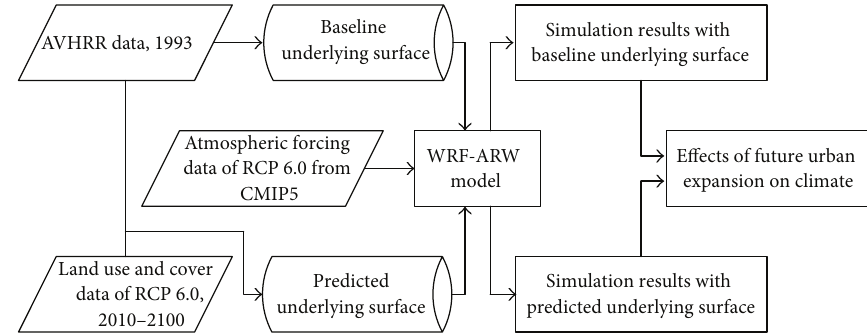
Figure 1: Simulation scheme and data processing